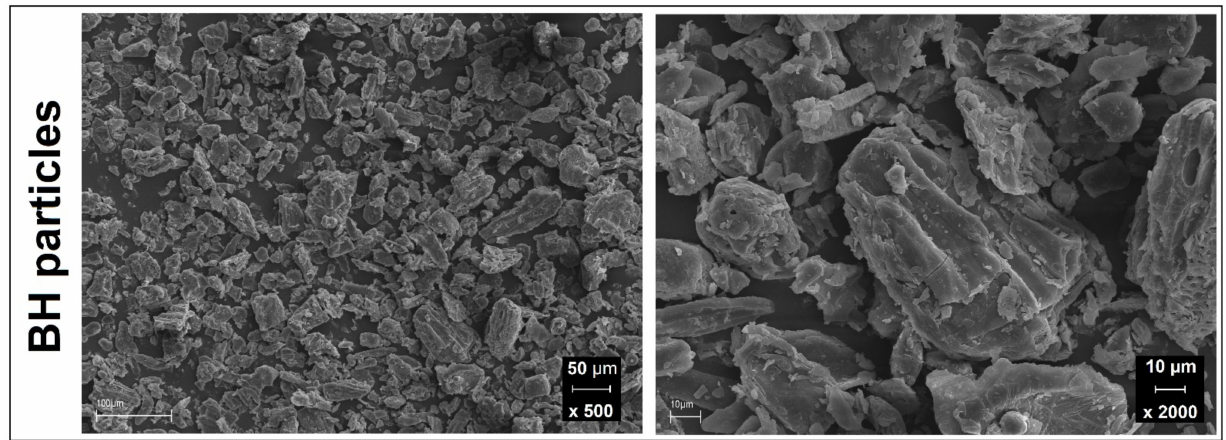
Figure 1. The appearance of the buckwheat husk particles after the sieving process, where the sieve size was <50 µ